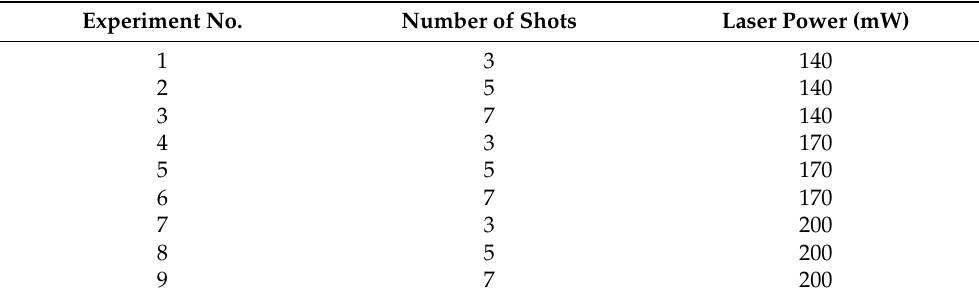
Table 1. Laser shock peening experiments settings of laser additive manufactured Inconel 718. Experiment